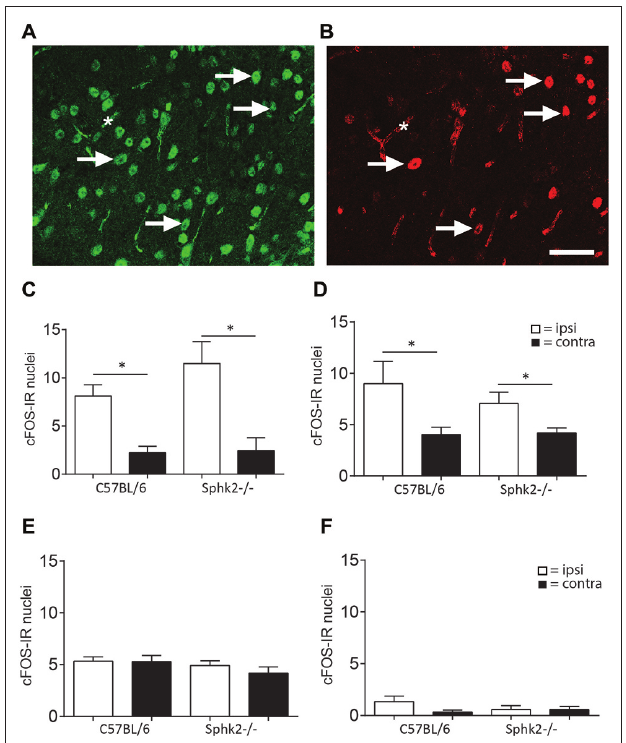
FIGURE 5 | IR for c-Fos in the dorsal horn of C57BL/6 and Sphk2 − / − mice in response to acute peripheral inflammation. (A,B) Double- labeling immunohistochemistry for NeuN and c-Fos. Nuclei with immuno-reactivity for NeuN (A) and c-Fos (B) in the ipsilateral SC dorsal horn after injection of formalin into the hindpaw. c-Fos positive nuclei also showed IR for NeuN. The arrows indicate some double-labeled nuclei. The asterisk indicates background labeling of capillaries. Bar = 50 µ m. (C) Number of nuclei with IR for c-Fos in the SC dorsal horn of C57BL/6 and Sphk2 − / − mice 60 min after injection of two percent formalin. (D) Number of nuclei with IR for c-Fos in the SC dorsal horn of C57BL/6 and Sphk2 − / − mice 60 min after injection of 0.5% formalin. (E) Number of nuclei with IR for c-Fos in the SC dorsal horn of C57BL/6 and Sphk2 − / − mice 60 min after injection of saline. (F) Number of nuclei with IR for c-Fos in the SC dorsal horn of C57BL/6 and Sphk2 − / − mice in untreated SC. Values represent mean ± SEM, n = 5, one-way ANOVA, Bonferroni’s post hoc test, * p < 0.05.